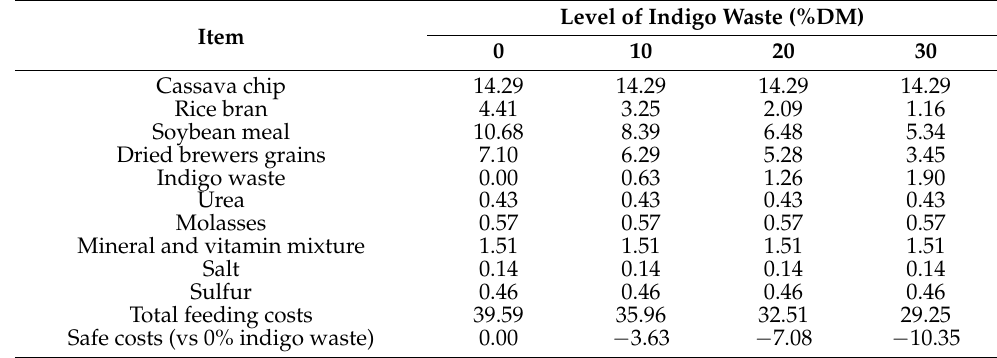
Table 2. Feed costs (USD/100 kg DM) of the experimental diets prepared with indigo waste.